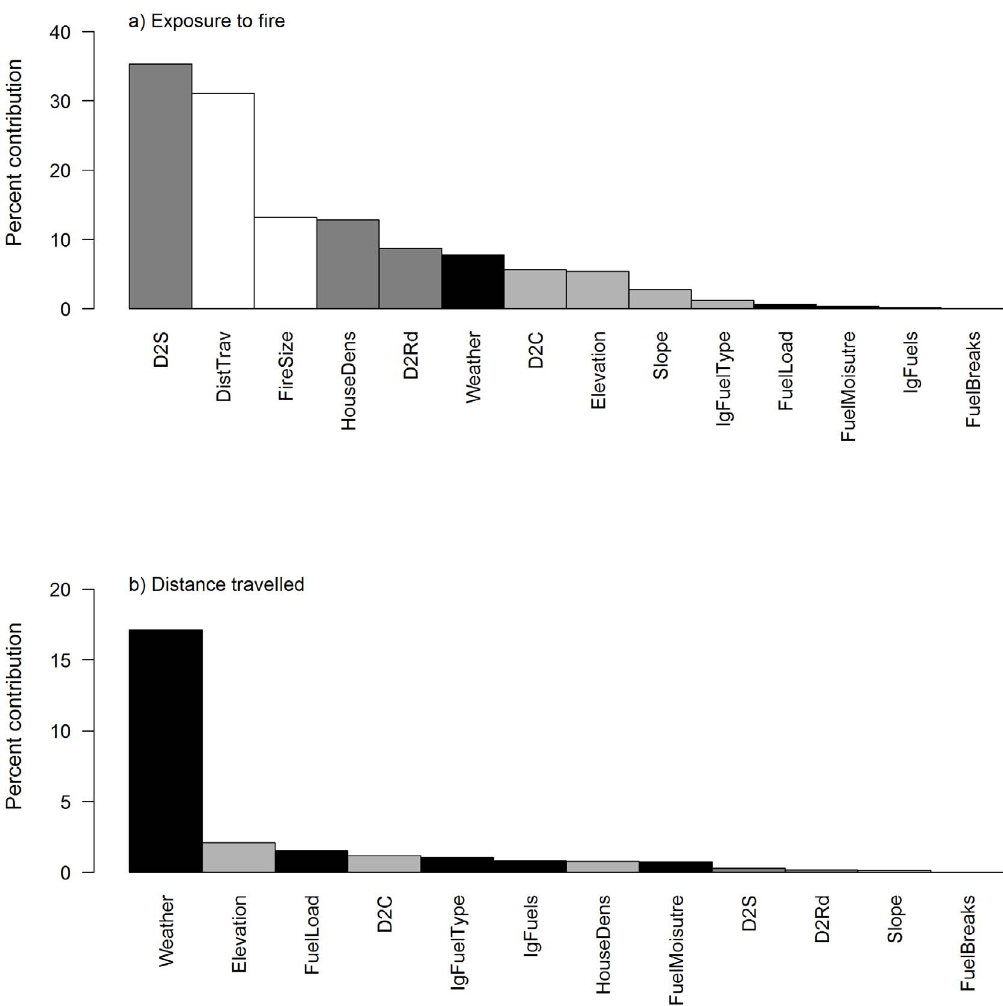
Figure 5. Sensitivity to findings for nodes a) Exposure to fire and b) Distance travelled. White bars=fire variables, dark grey bars=built environment variables; light grey bars=natural environment variables; Black bars=simulation model variables. D2S=distance to structure; DistTrav=distance travelled by the fire; HouseDens=housing density; D2Rd=Distance to road; D2C=distance to the coast; IgFuelType=fuel type at the point of ignition; IgFuels=fuel load at the point of ignition; FuelBreaks=presence of fuel breaks.